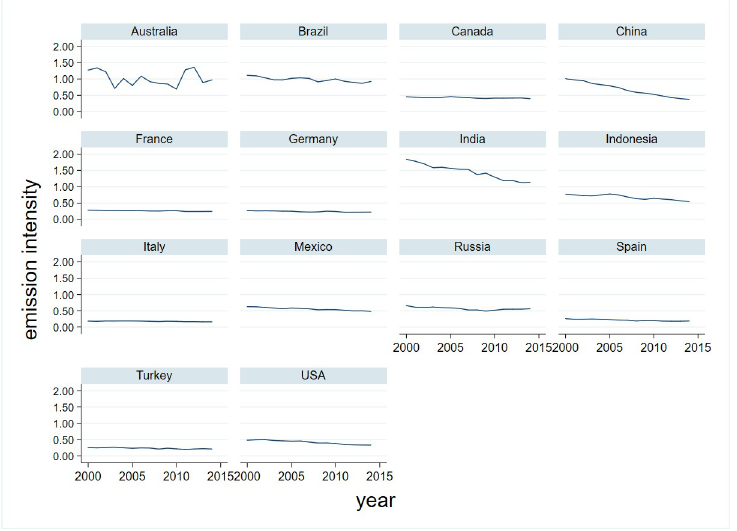
Fig 3. Emission intensity of food production in the examined countries in 2000–2014 (kg CO 2 eq per USD 1 worth of food production global output). Source: Authors’ calculations (in STATA 15) based on data from WIOD Environmental Accounts (Update 2000–2016), WIOD, Release 2016 and FAO Emissions